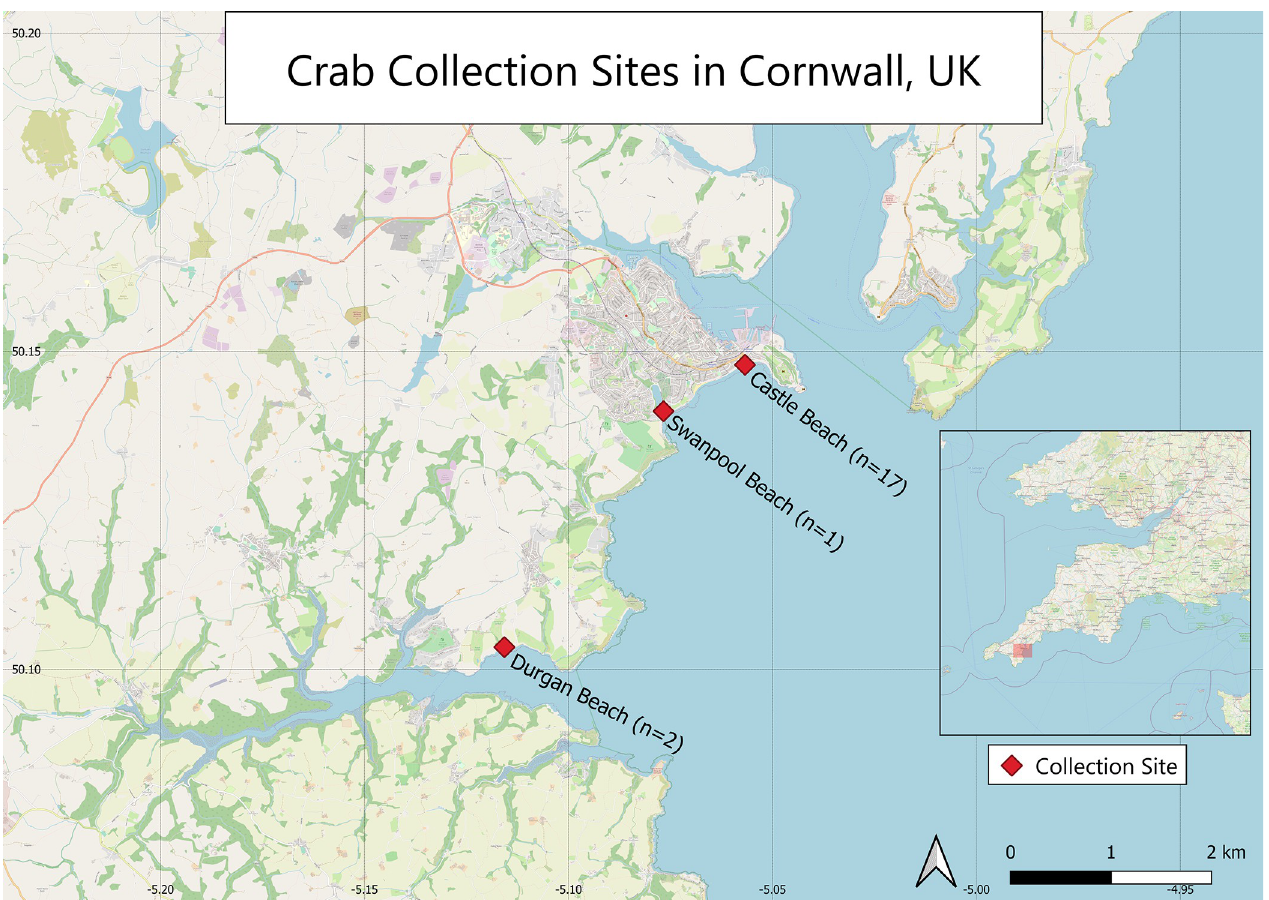
Fig 1. Map of crab collection sites Durgan, Swanpool and Castle beaches located around the southwestern coast of Cornwall with number of crabs caught at each site.